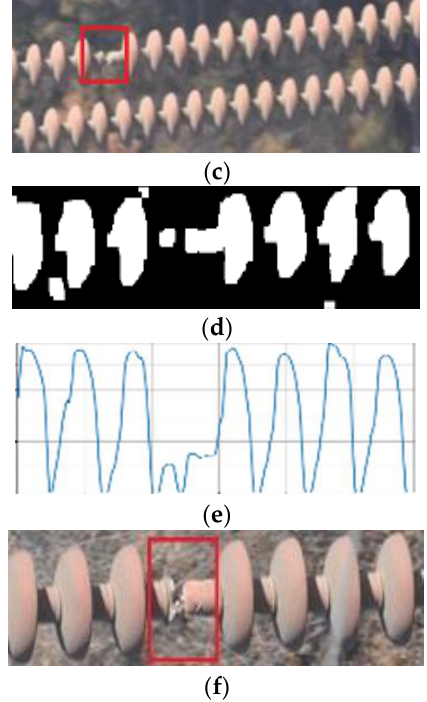
Figure 11. Binary images of insulators and their corresponding pixel statistical charts. ( a ) Binary image of insulators, ( b ) pixel statistical chart, ( c ) location of the missing cap in the RGB image, ( d ) binary image of insulators with noise, ( e ) pixel statistical chart with noise, ( f ) location of the missing cap in the RGB image.